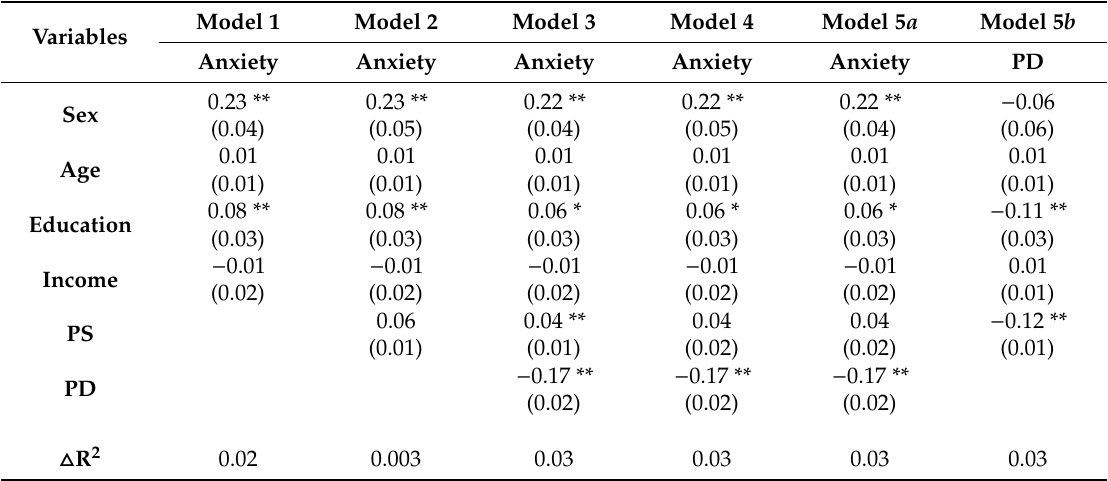
Table 2. Cross-level mediation analysis for pandemic severity, psychological distancing, and anxiety. Model Variables